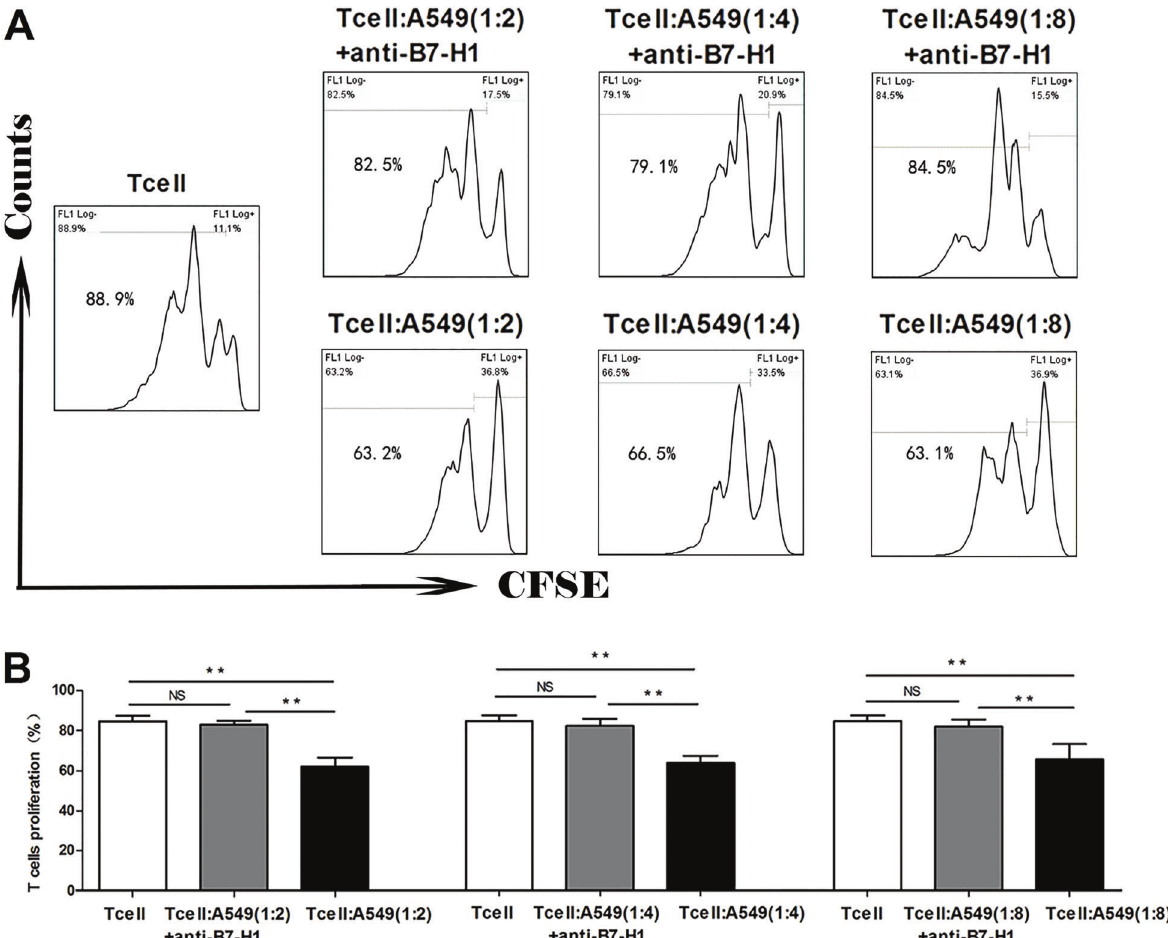
Figure 1. A , Representative fl ow cytometry graphs for each experimental group, with the percentage of proliferating Tcells (cells left to the fi rst peak of carboxy fl uorescein succinimidyl ester (CFSE) + cells) labeled in the graph. B , Quantitative analysis of proliferating T cells among different groups. Tumor-associated B7-H1 is essential for regulating T-cell proliferation. T cells isolated from human peripheral blood mononuclear cells were labeled with CFSE, stimulated with anti-CD3 and anti-CD28, and co-cultured with Tcells alone or with A549 cells at the T:A549 ratios of 1:2, 1:4 or 1:8, in the absence ( + A549) or presence of anti-B7-H1 ( + anti-B7-H1). T-cell proliferation was examined by fl ow cytometry after 72 h. NS: non-signi fi cant. **P o 0.01